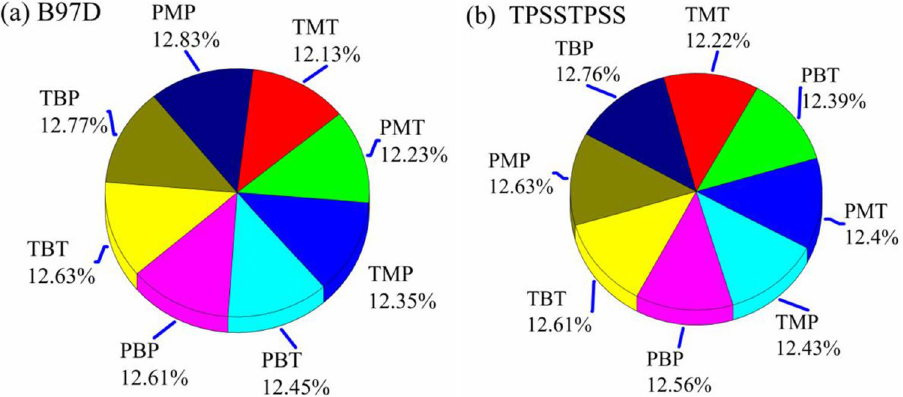
Figure 8. A 3D color pie chart for the computed RMSEs computed by ( a ) B97D and ( b ) TPSSTPSS functionals versus the different combinations (geometry level and basis set) (Notice: T and P correspond, respectively, to TZVP and 6–311 + G(2d,p), B and M correspond to B3LYP and M06-2X geometry functionals).